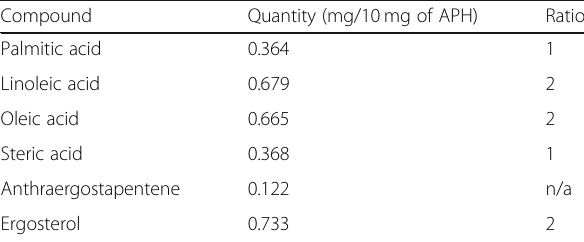
Table 3 Quantitative analysis of APH analysis by GC-MS Compound Quantity (mg/10 mg of APH) Ratio Palmitic acid